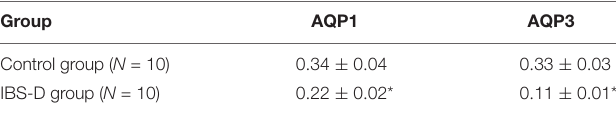
TABLE 2 | Expression of AQP1 and AQP3 in two groups of subjects.